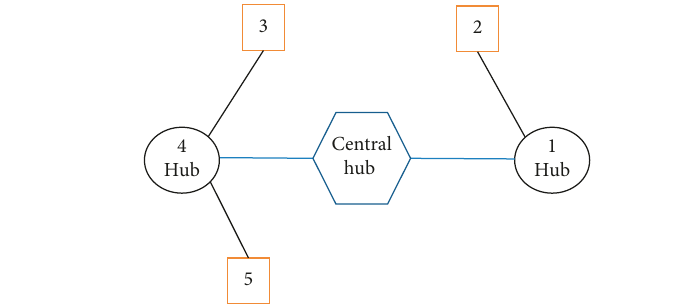
Figure 6: Network design [26].